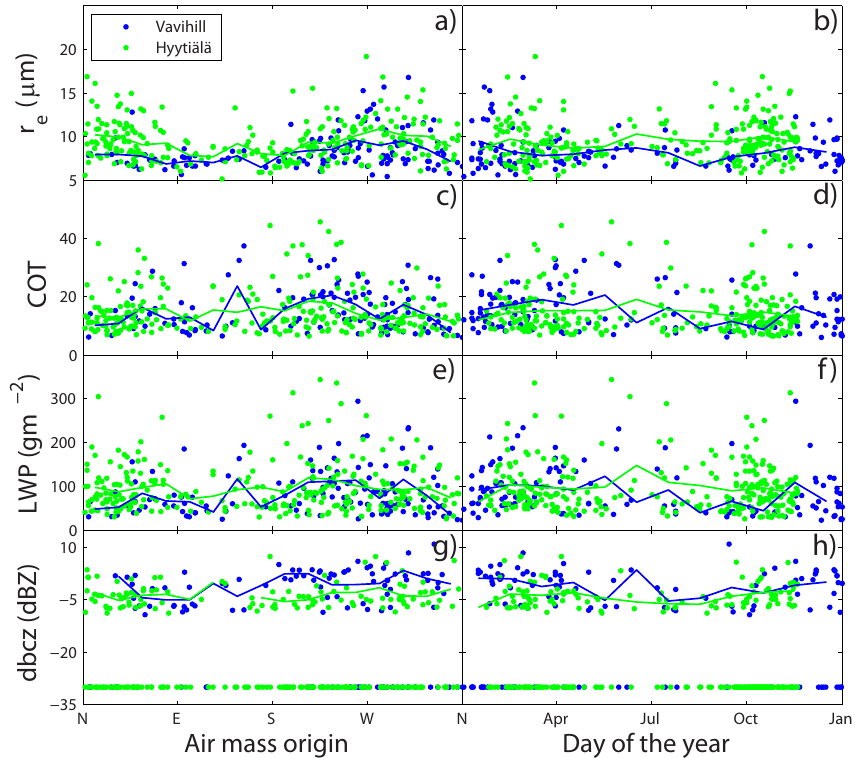
Figure 4. Effective radius ( r e ), cloud optical thickness (COT), liquid water path (LWP) and radar reflectance (dbcz) plotted against air mass origin (a, c, e, g) and day of the year (b, d, f, h) for Vavihill (blue dots) and Hyytiälä (green dots). The lines in the figures are mean values over 22.5 ◦ (a, c, e, g) and over 30 days (b, d, f, h) .